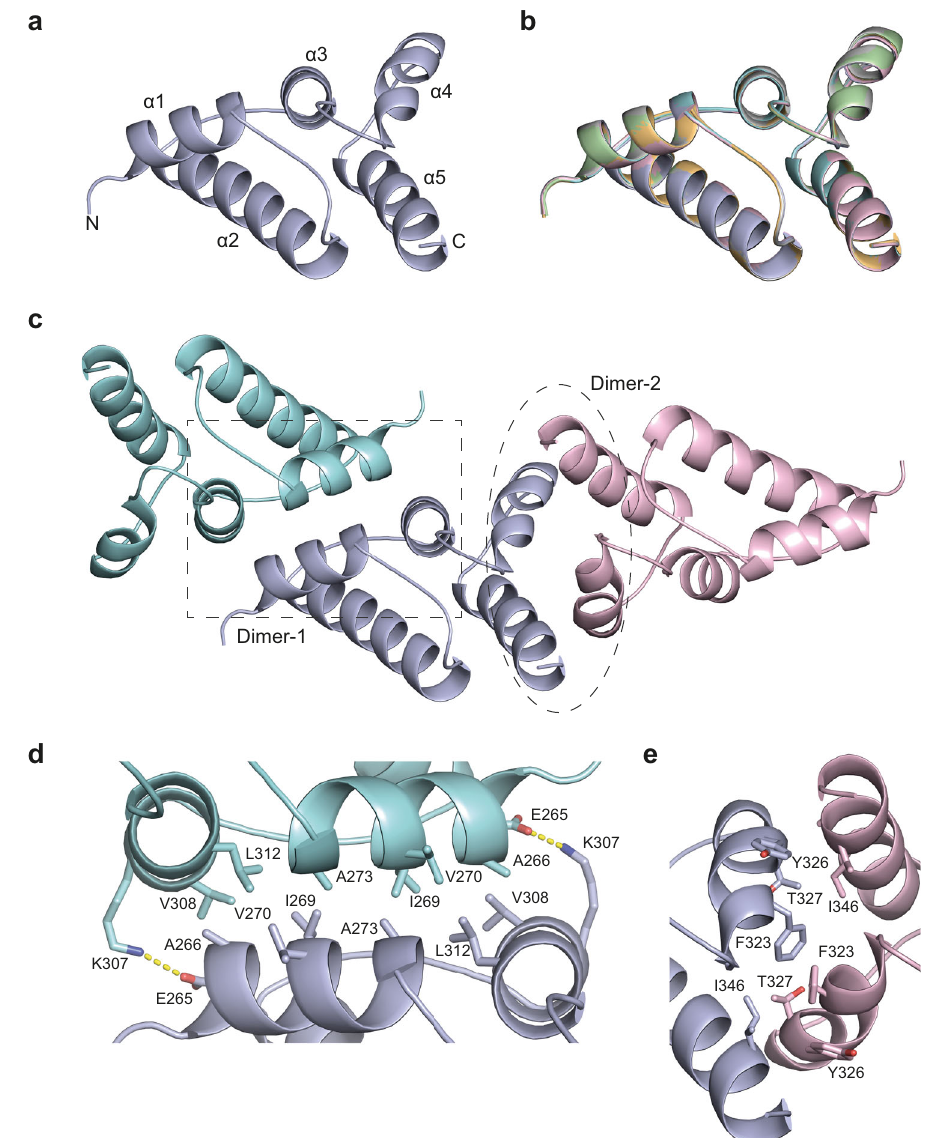
Fig. 2 Crystal structure of p18m. a Crystal structure of p18m monomer, the protein backbone is shown in cartoon representation. The fi ve α -helices in the structure are labelled sequentially from the N- to C-terminus. b 3D structural alignment of all six copies of p18m present in the AUG1 and AUG2 structures. The view is the same as in a . Individual monomers are shown in cartoon representation coloured light-blue, cyan, pink, orange, grey, and green. Structures were aligned using backbone C α atoms (RMSD 0.16 ± 0.04 Å over 82 C α ). c The trimer asymmetric unit of the p18m crystal structure. The three p18m protomers are shown in cartoon representation coloured cyan, light-blue and pink respectively. The dimer interfaces between protomers (Dimer-1 and Dimer-2) are highlighted with the grey box and ellipse respectively. d Close-up view of the Dimer-1 interface, the box-highlighted region in ( c ). Residues on helices α 1 and α 3 that make apolar and salt bridge interactions are shown in stick representation. The E265 and K307 salt bridge is indicated by the dashed lines. e Close-up view of the Dimer-2 interface, the ellipse-highlighted region in ( c ). Residues on helices α 4 and α 5 that make the hydrophobic interactions are shown in stick